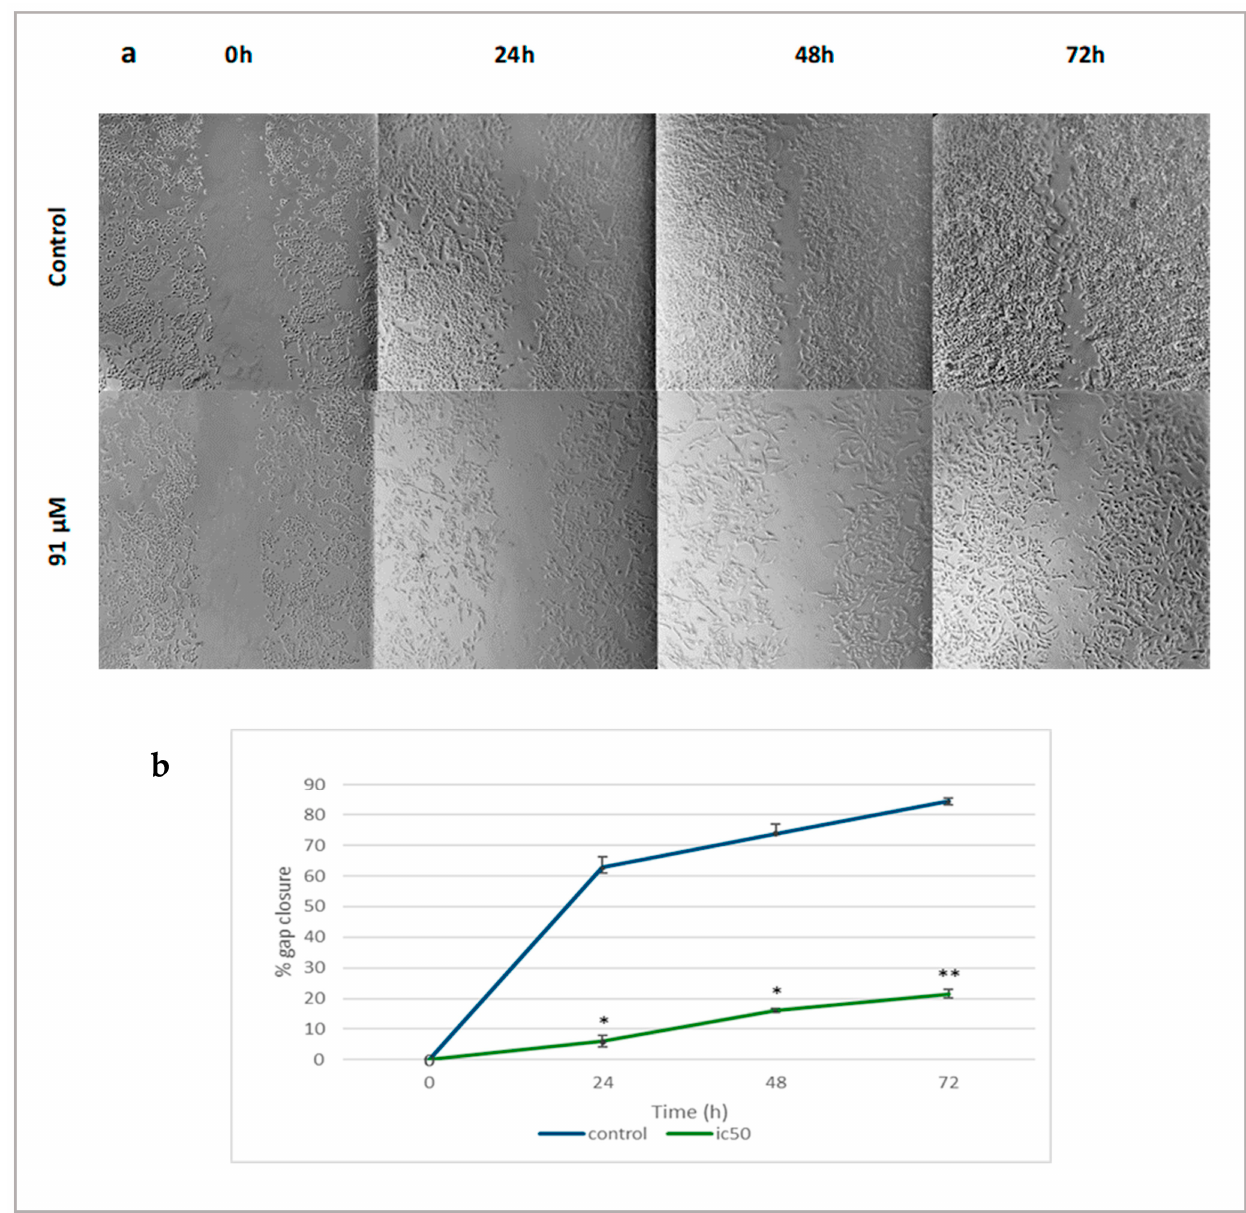
Figure 8. Microscopic images (magnification × 10) of scratch wound healing assay. ( a ) When T98 cells were treated with an IC50 linearol concentration, a decrease in the closure percentage was observed. ( b ) The migration ability of T98 cells showed a statistically significant decline after treatment with linearol when compared to control (91 μ M at 24 h: 6.05%, p < 0.05; 91 μ M at 48 h: 16.06%, p < 0.05 and at 72 h: 21.56%, p < 0.001). Data are presented as the mean ± SD. * p < 0.05, ** p < 0.001 compared to the control group.